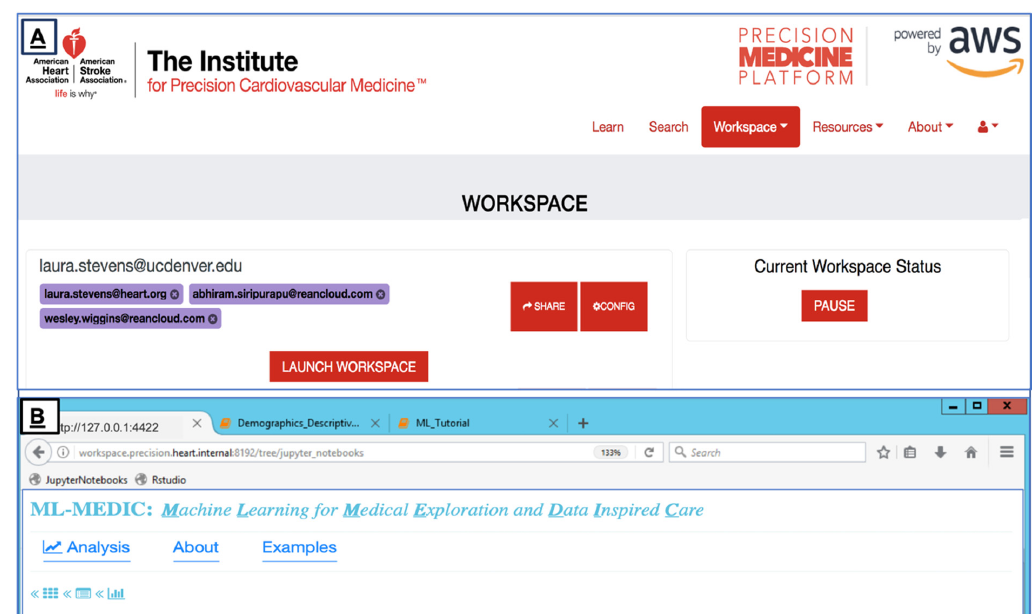
Figure 1. The Precision Medicine Platform. ( A ) The landing page of the workspace for the cloud ‐ based, High Performance Computing ‐ enabled platform ML ‐ MEDIC in the Precision Medicine Platform that supports multiple collaborators (red box) to work in a secure virtual environment. ( B ) ML ‐ MEDIC deployed in the platform, enabling reproducibility and accessibility. ML ‐ MEDIC, Machine Learning for Medical Exploration and Data ‐ Inspired Care.